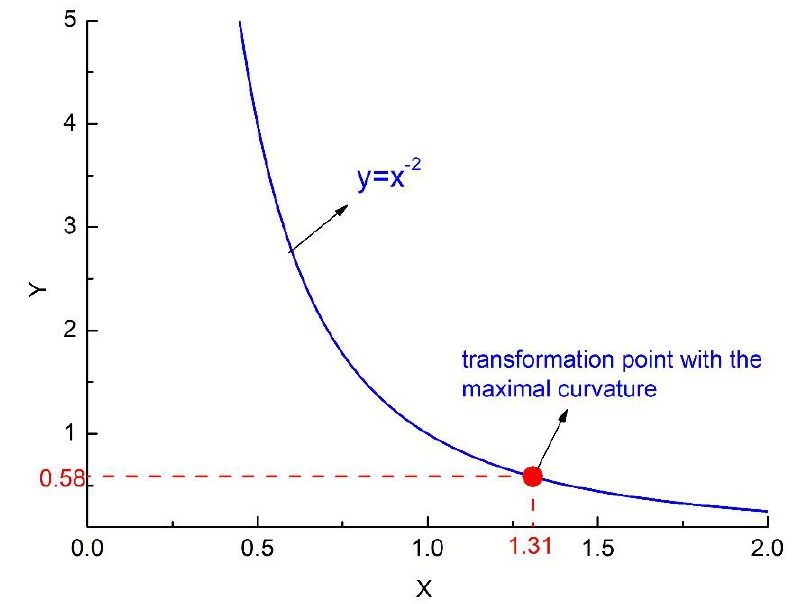
2 y x   and its transformation point with the maximal curvature. 182 (cid:95) (cid:95) m ( x ) in the maximal curvature point as the threshold